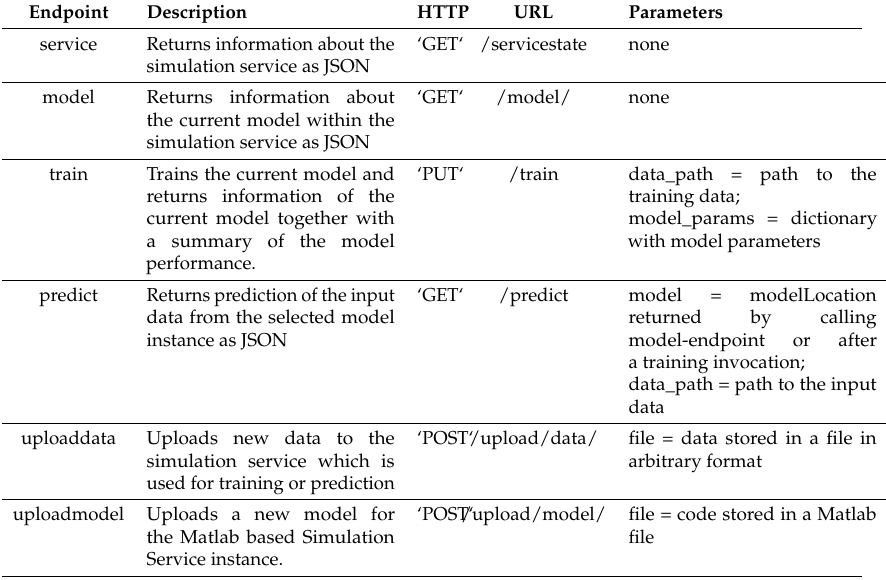
Table 2. Hypertext Transfer Protocol (HTTP) endpoint description for the implemented Simulation Service Application Programming Interface